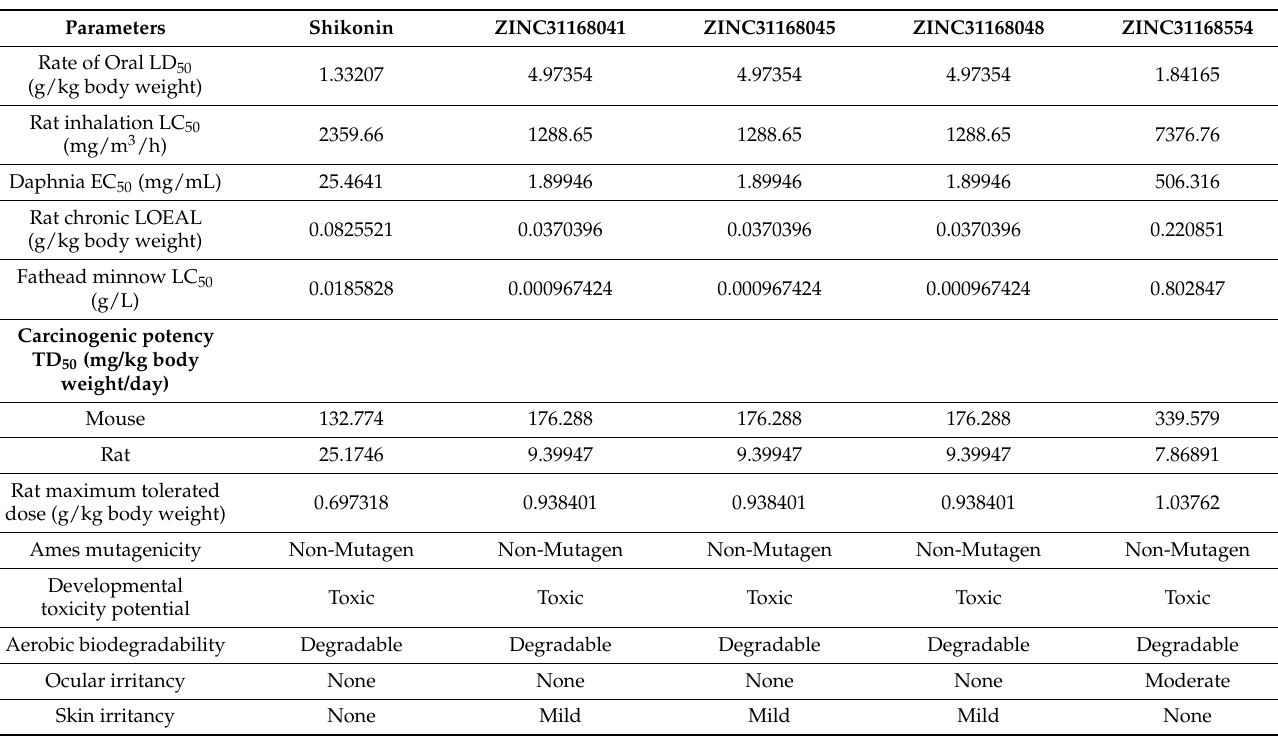
Table 3. Computational values of toxicity and carcinogenicity predicted for Shikonin and top four filtered molecules by Biovia Discovery Studio.